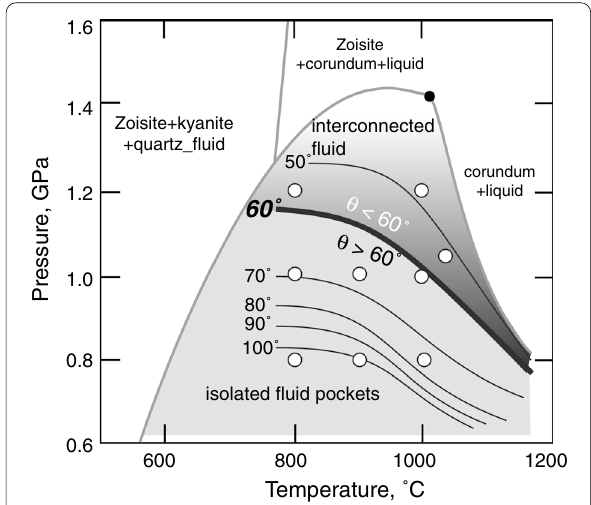
Fig. 38 Pressure–temperature relations of dihedral angles as indicated for the system anorthite–H 2 O. Stability limit of the CaAl 2 Si 2 O 8 –H 2 O system is from Boettcher (1970). Modified from H 2 O NaCl at 800 °C + + Yoshino et al.